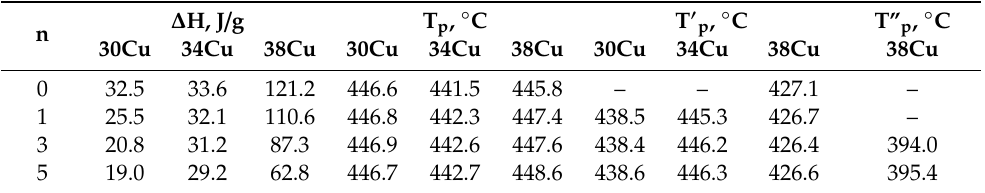
Figure 6. DSC curves for the crystallization of the TiNiCu alloys with 30 at.% Cu ( a ) and 38 at.% Cu ( b ) in the initial state and after HPT to n = 1, 3, and 5. Table 1. Crystallization enthalpy and peak temperatures of the TiNiCu alloys in the initial amorphous state and after HPT.